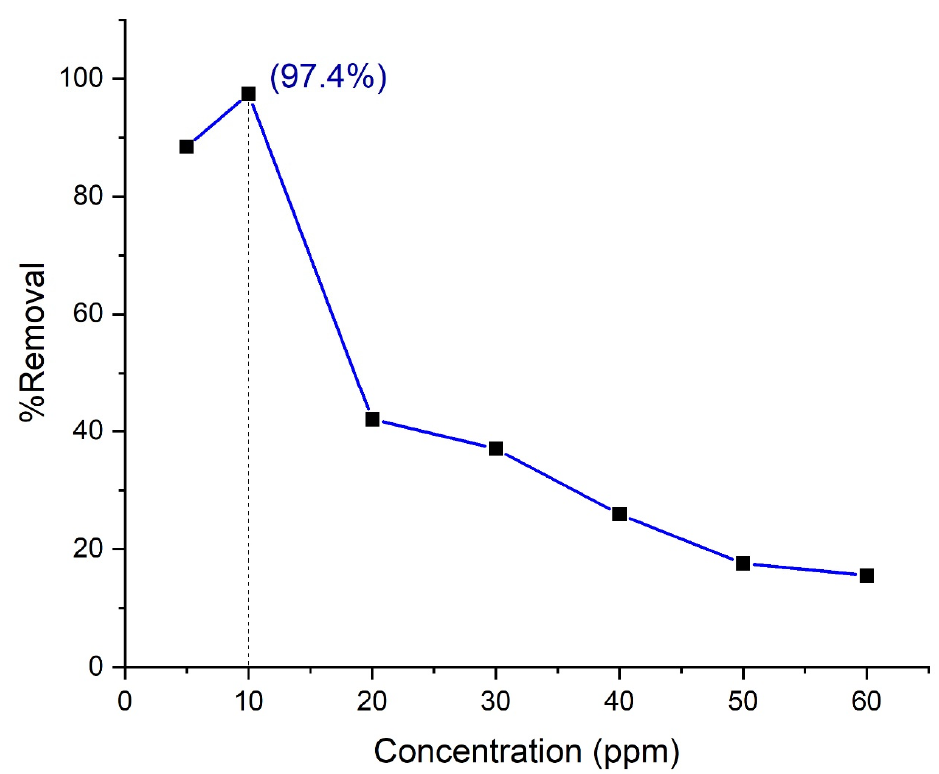
Figure 11. Effect of solution concentration on the removal of Orange G by nanohybrid Composite 3 (TP 0.75 CS 0.25 ). The pH was maintained at 2.5, and the amount of adsorbent was 0.2 g/L. As initial dye concentration increases, the concentration gradient gradually rises be- tween dye molecules and the nanohybrid surface. This gradient of concentration plays a pivotal role to draw dye molecules onto the surface of the material. As long as the satura- tion of the surface does not occur, the adsorption of the dye molecule continues to escalate. That is why a sharp upward curve has been found initially with the increase of dye con- centration. The saturation of the material surface has seemingly occurred at 10 mg/L in this study, which can be attributed to the fact all the free active sites on the surface are covered by dye molecules at this concentration. Therefore, it is obvious that a decline in dye removal efficiency will happen at any concentration above 10 mg/L for a fixed dose